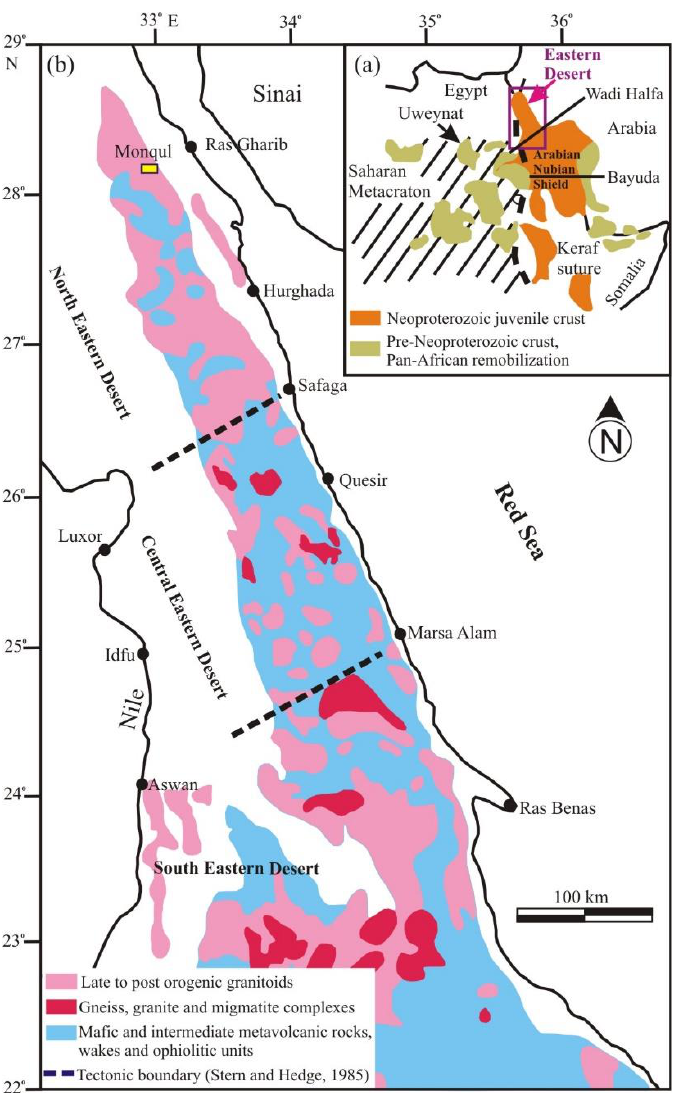
Figure 1. ( a ) Geologic map showing the Arabian – Nubian Shield (ANS); ( b ) geologic map showing the basement rocks of the Neoproterozoic age in the ED of Egypt [20].